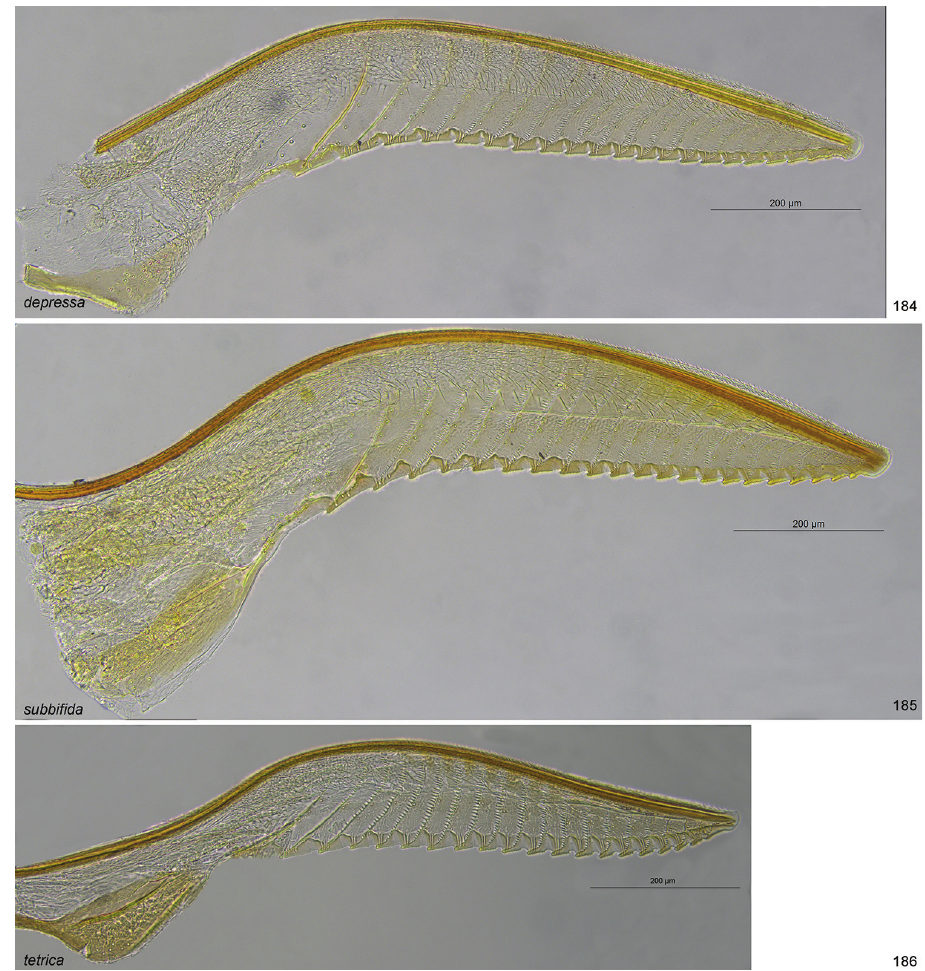
Figures 184–186. Lancets of Pristiphora . 184 depressa DEI-GISHym17704 185 subbifida DEI- GISHym80062 186 tetrica